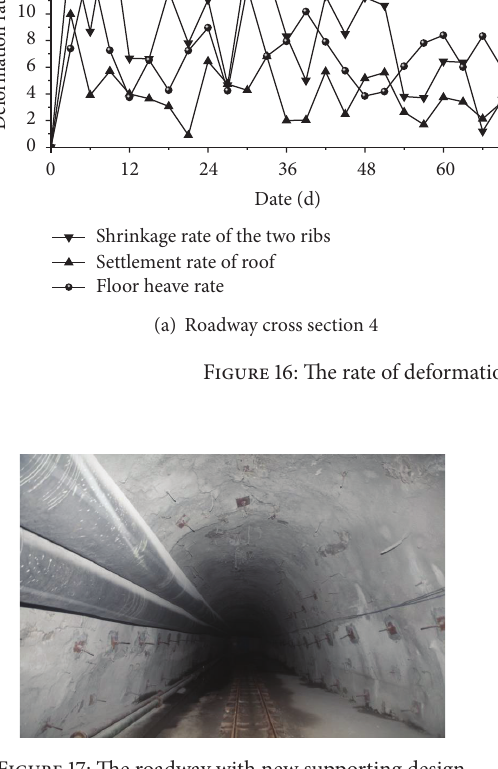
Figure 17: The roadway with new supporting